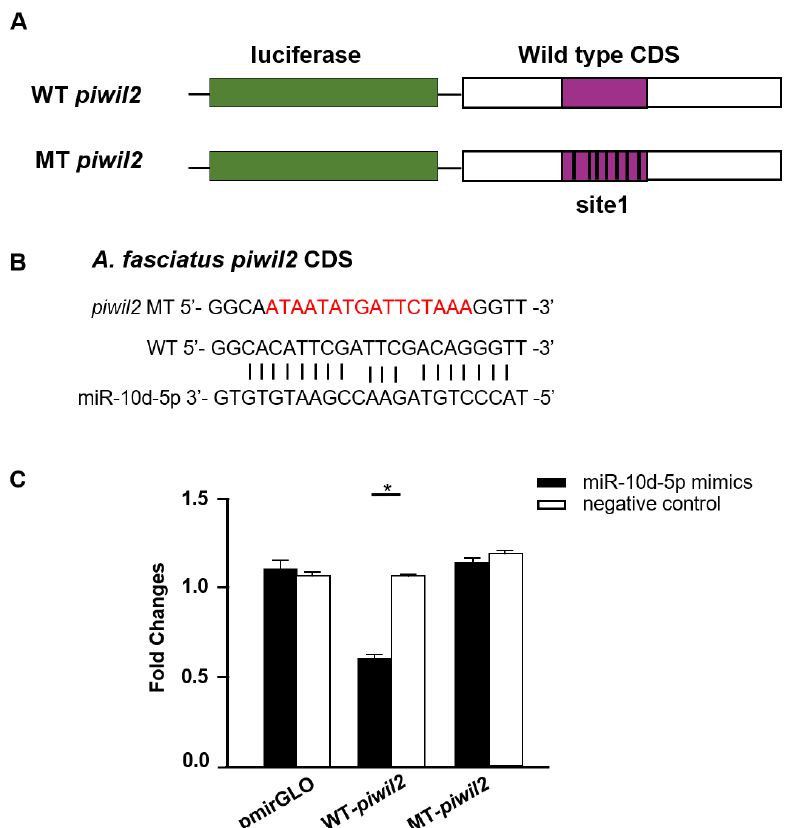
Figure 8. Prediction map of miR-10d-5p and piwil2 target site and the luciferase activity of miR-10d-5p and piwil2 . ( A ) The CDS region of piwil2 has a targeting relationship with miR-10d-5p. ( B ) The specific prediction diagram of miR-10d-5p and target gene at the binding site. ( C ) The luciferase activity of miR-10d-5p and piwil2 . *: 0.01 < p < 0.05.